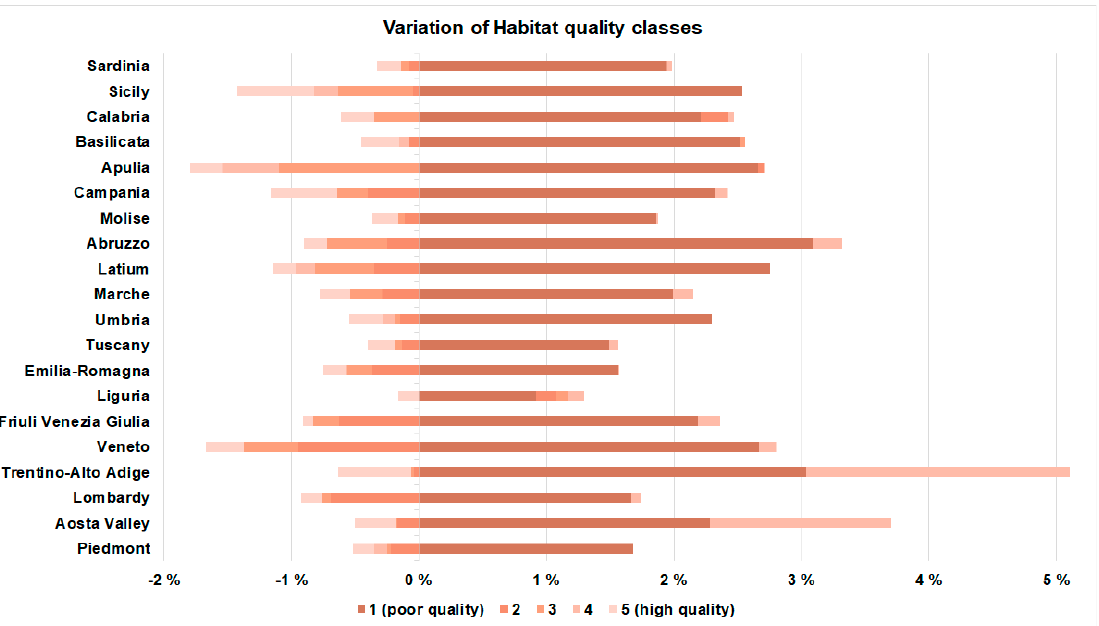
Figure 8. Percentage surface variation of habitat quality classes due to land consumption in the period 2012–2020 at the regional level.